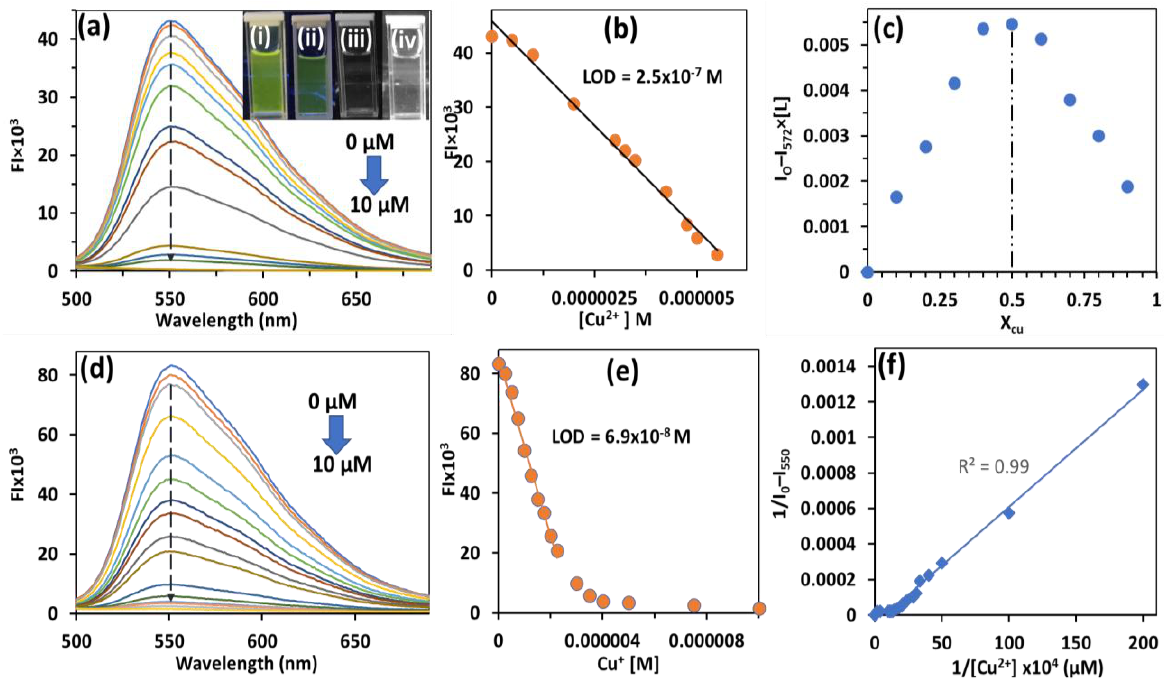
Figure 5. ( a , d ) Emission spectrum of HBT 2 (0.5 μM) upon addition of Cu 2+ and Cu + ions recorded in 90% HEPES buffer – CH 3 CN, pH 7.2; ( b , e ) plot of fluorescence intensity versus conc. of Cu 2+ ions for calculating the limit of detection; ( c ) Job’s plot showing 1:1 stoichiometry between HBT 2 and Cu 2+ ions; and ( f ) B – H plot between I/I o – I 550 and 1/Cu 2+ ion; [Inset of ( a )] Photographs (under 365 nm UV lamp) showing quenching of fluorescence of ( i ) HBT 2 upon addition of ( ii ) 5, ( iii ) 10 and ( iv ) 20 equivalents of Cu 2+ ions.